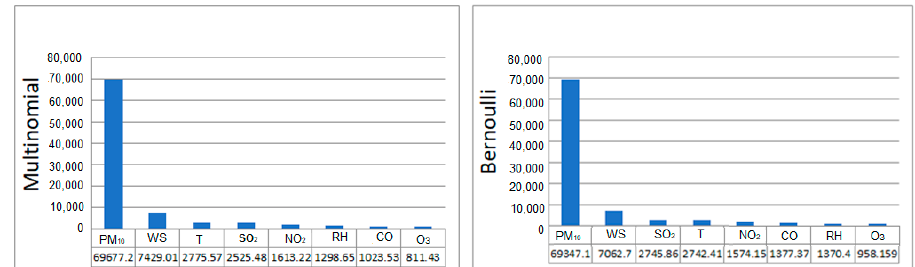
Figure 5. Feature importance for eight parameters (boosted regression tree (BRT) model).